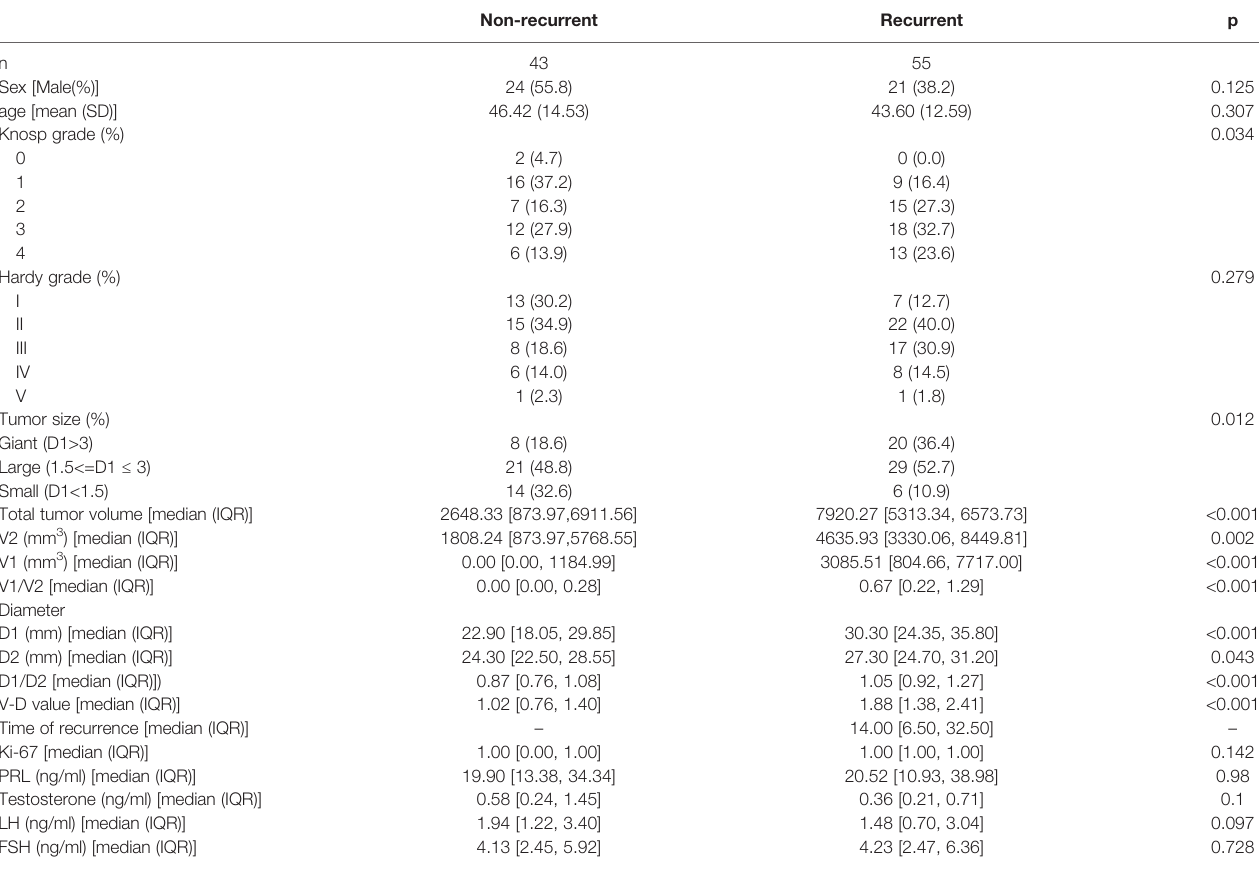
TABLE 1 | Baseline information (data of normal distribution were shown as means (standard deviation), data that did not fi t the normal distribution were shown as means (median, interquartile